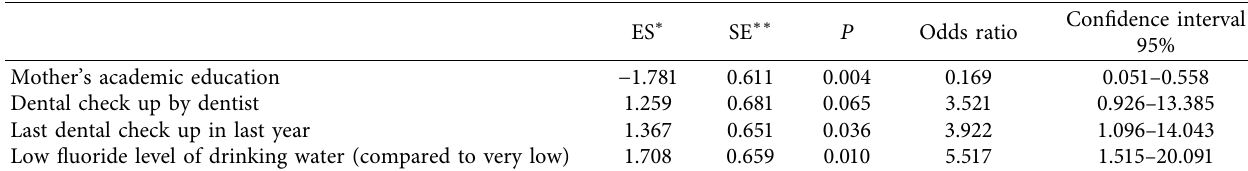
Table 3: Association of independent variables (including genotype of AMELX gene) with the caries status in the control group (caries free) compared to case group (DMFT ≥